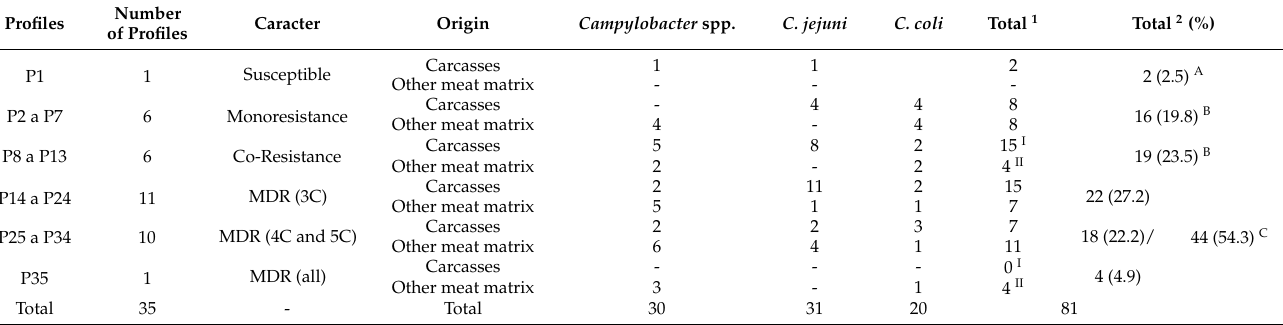
Table 5. Multidrug resistance profiles of Campylobacter isolated from different meat matrices.